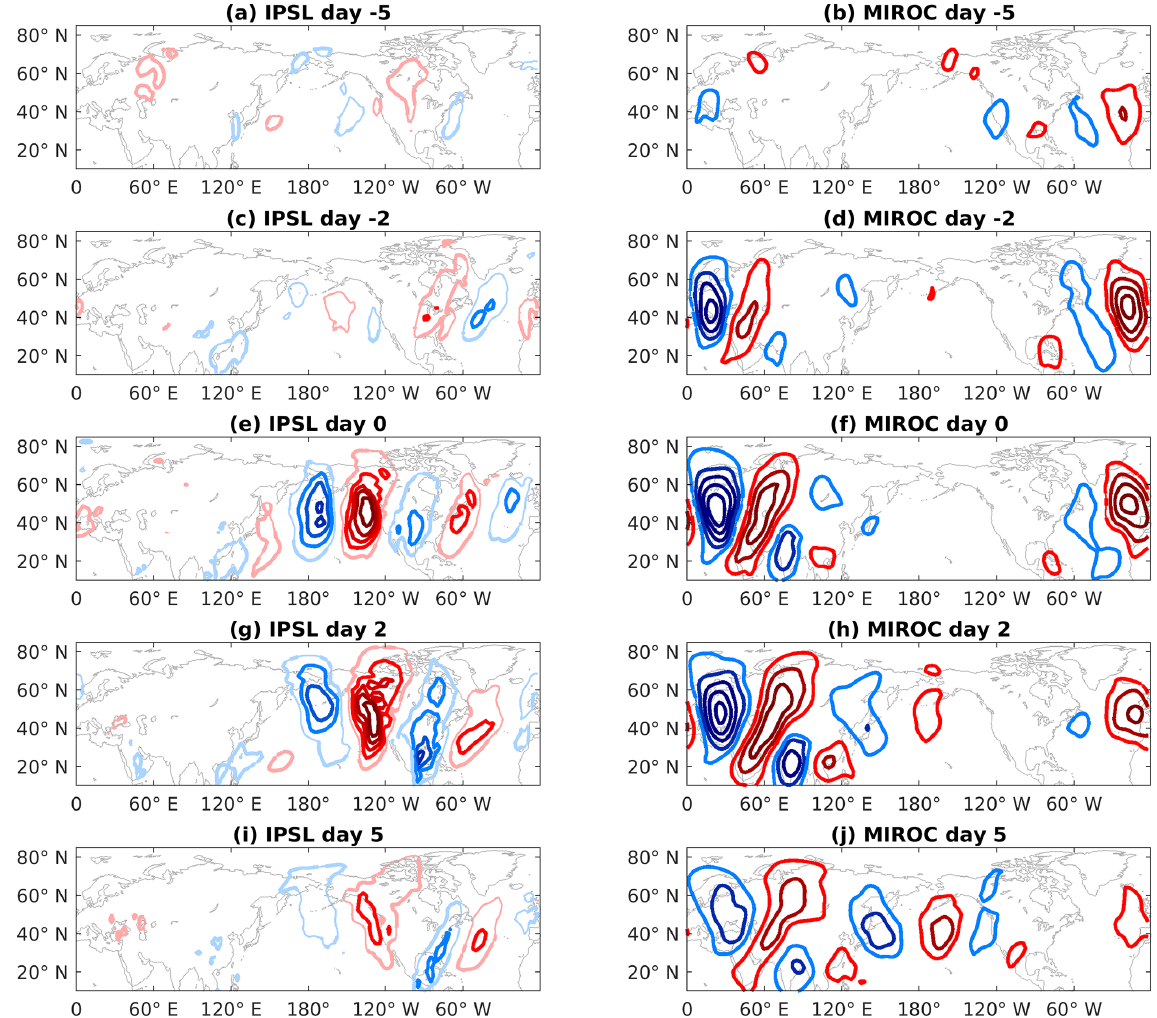
Figure 10. Lag composite of CTP events for days − 5, − 2, 0, 2, and 5. The composites are comprised of 500hPa daily V deviations from RCP8.5 mean (2006–2099), for IPSL-CM5A-MR (a, c, e, g, i) and MIROC-ESM-CHEM (b, d, f, h, j) . The IPSL (MIROC) composite consists of 222 (165) events. The contour interval is 1ms − 1 for the IPSL plots and 2ms − 1 for the MIROC plots. Thick contours mark 95% statistical confidence under a bootstrap two-tail t